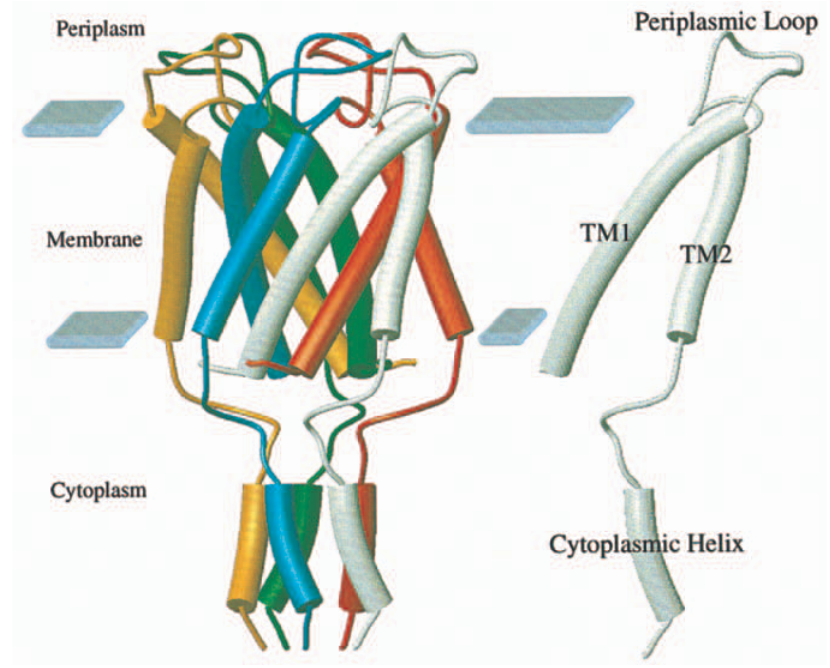
Figure 5. Diagram of the MscL pentamer from Mycobacterium tuber- culosis according to the three-dimen- sional structural model proposed by Chang et al. (1998). The pentamer (left) and a single monomer (right) are shown. The transmembrane helices TM1 and TM2 are labeled. Solid blocks denote the location of the mem- brane interface with the periplasmic and cytoplasmic spaces. This figure was produced by MolScript (Avatar Software, Stockholm, Sweden; Kraulis 1991) (adapted from Oakley et al.